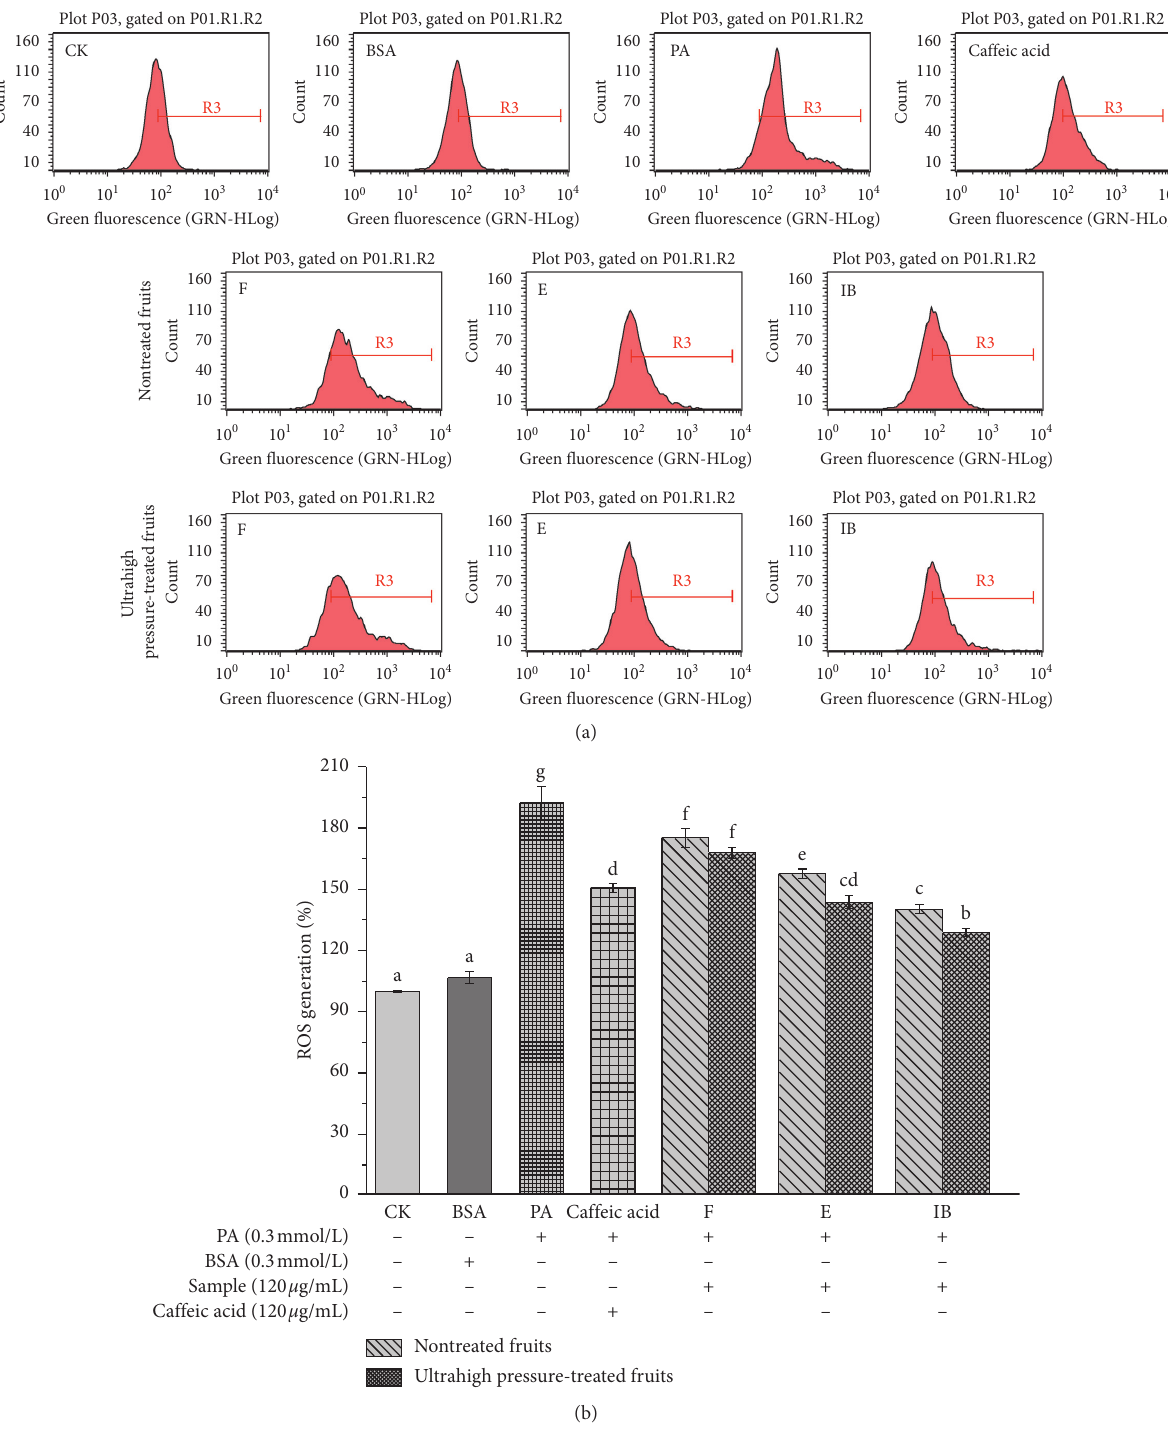
Figure 2: The inhibitory effects of phenolic fractions from oil palm fruits with or without ultrahigh pressure treatment and caffeic acid on PA-induced ROS generation: flow cytometry analysis (a) and the relative amount of ROS of different groups (b). Data are expressed as mean ± SD ( n � 3). In Figure 2(b), mean values with different letters are significantly different ( p < 0 . 05). CK: control group; BSA: BSA/ NaOH complex solution; PA: PA/BSA complex solution; “F” free phenolic fraction; “E” esterified phenolic fraction; “IB” insoluble-bound phenolic